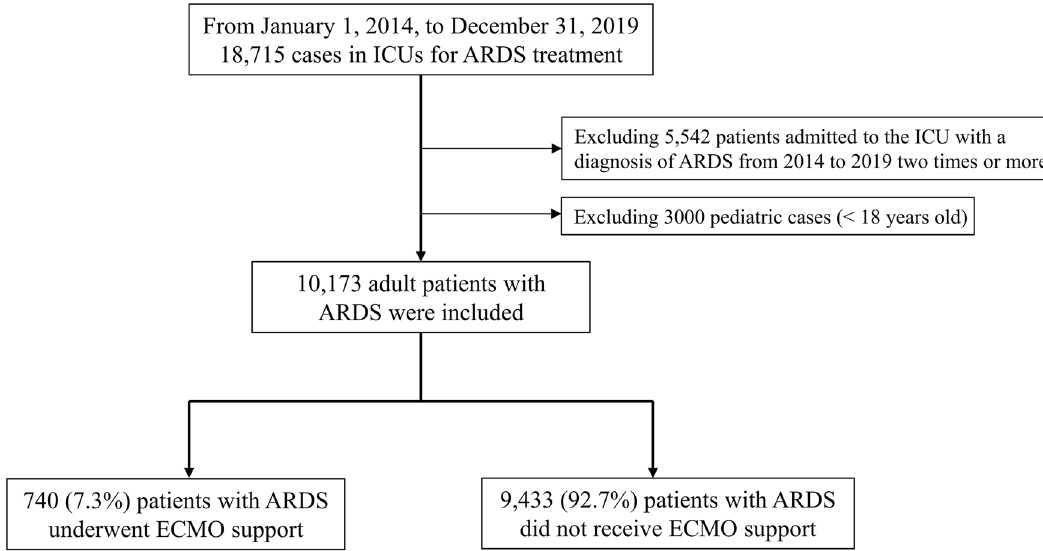
Figure 1. Flow chart depicting the selection process of patients with ARDS patient. ARDS. Acute respiratory distress